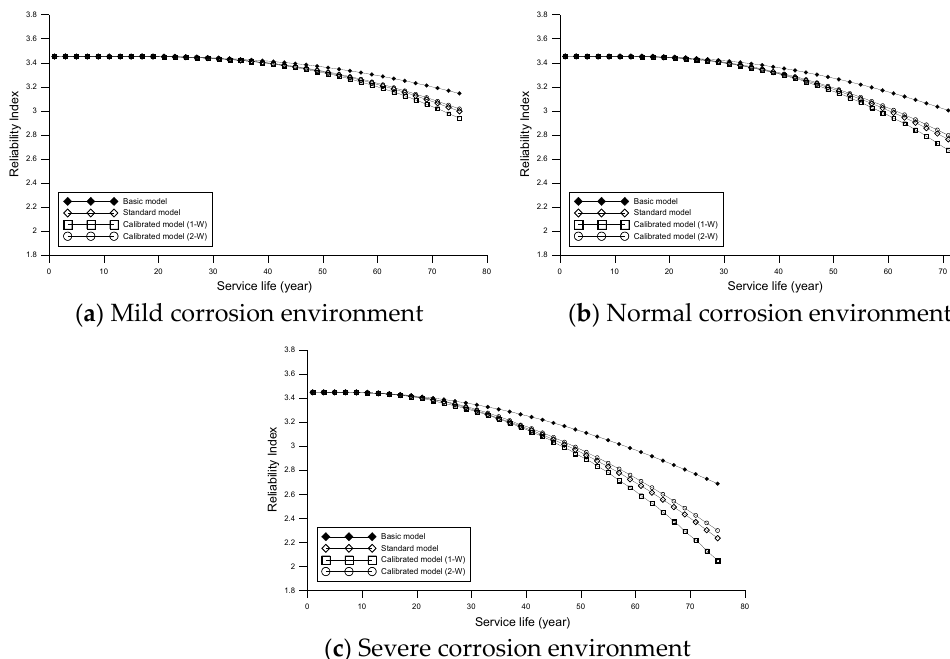
( b ) Normal corrosion environment